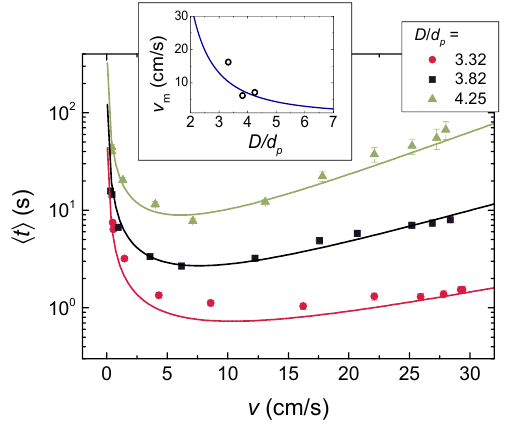
Figure 3. Experimental mean avalanche durations as function of the velocity of beads for the three aspect ratios shown in the legend. The solid lines are plots of Eq. 7 with the values of the parameters indicated in the text. The solid line in the inset is a plot of Eq. 8, which relates the beads velocities at which the mean avalanche duration is minimum with respect to D / d p . The empty circles are experimental values of v for which the three values of D / d p explored in this work.